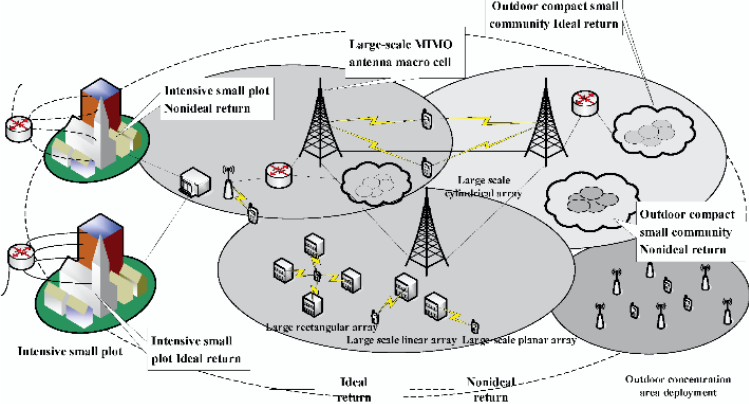
Fig. 4. Application scenarios of massive multi-antenna MIMO